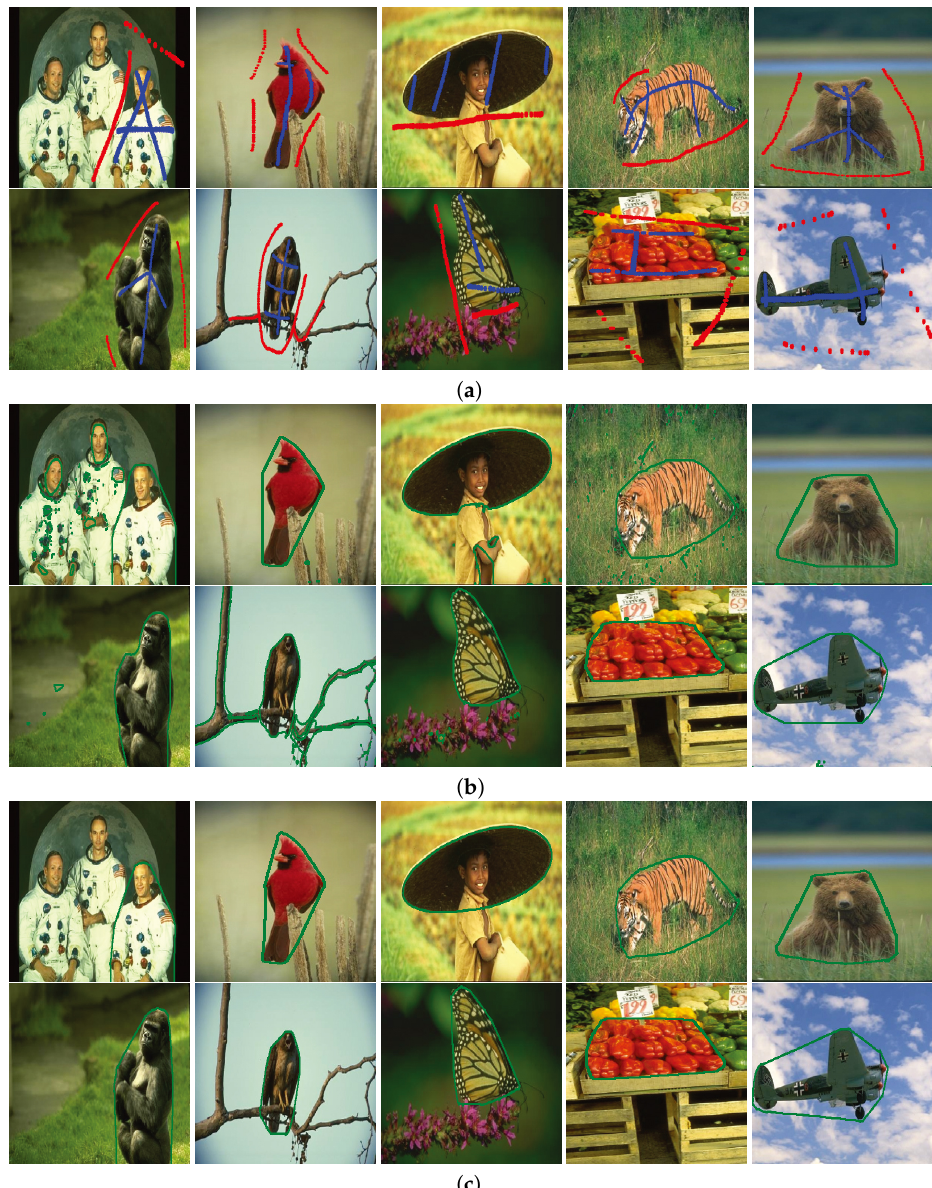
Figure 2. Different convex shape image segmentation results for images in BSDS500, where ( a ) shows ten original images on which blue and red markers were used to differentiate the foreground region and the background region, respectively, and ( b , c ) were corresponding image segmentation results of ( a ) obtained from the BLF–TV–CS method and our proposed PPA–CS method,